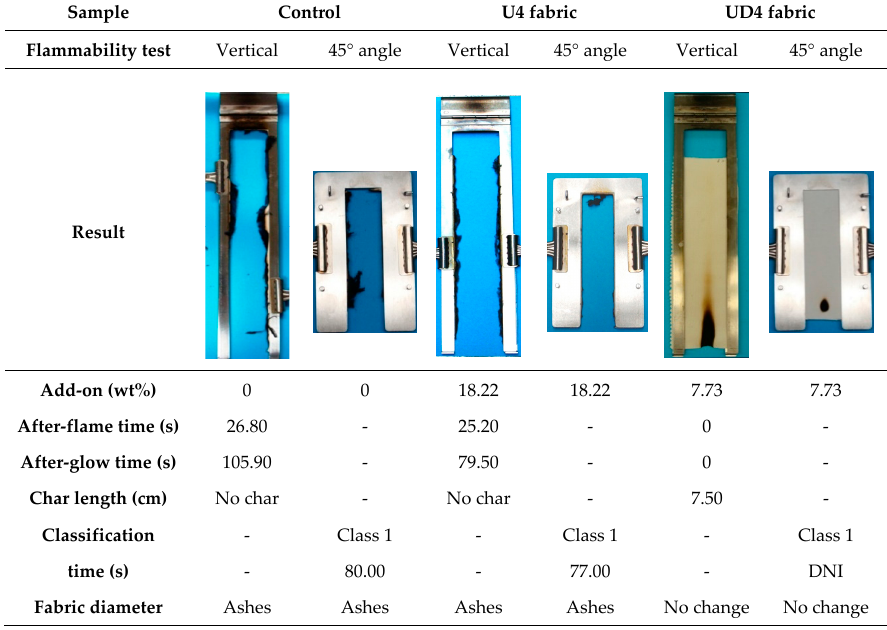
Figure 3. Vertical and 45° angle flammability test results of control and highest add-ons (wt%) for urea only (U4) and urea/DAP (UD4) treated sample.